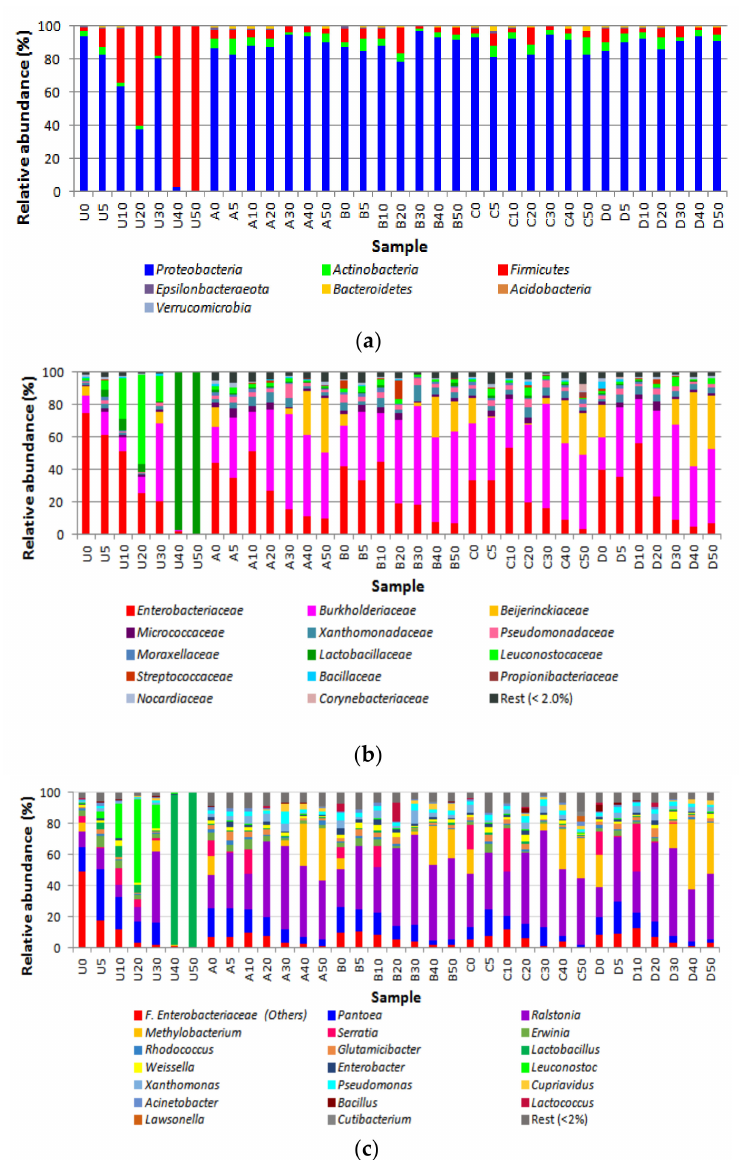
Figure 1. Bacterial diversity of guacamole samples at phylum ( a ), family ( b ), and genus ( c ) levels. U, untreated controls. HP treatments: A, 450 MPa at 22 ◦ C; B, 450 MPa at 50 ◦ C; C, 600 MPa at 22 ◦ C; and D, 600 MPa at 50 ◦ C. Numbers indicate incubation time